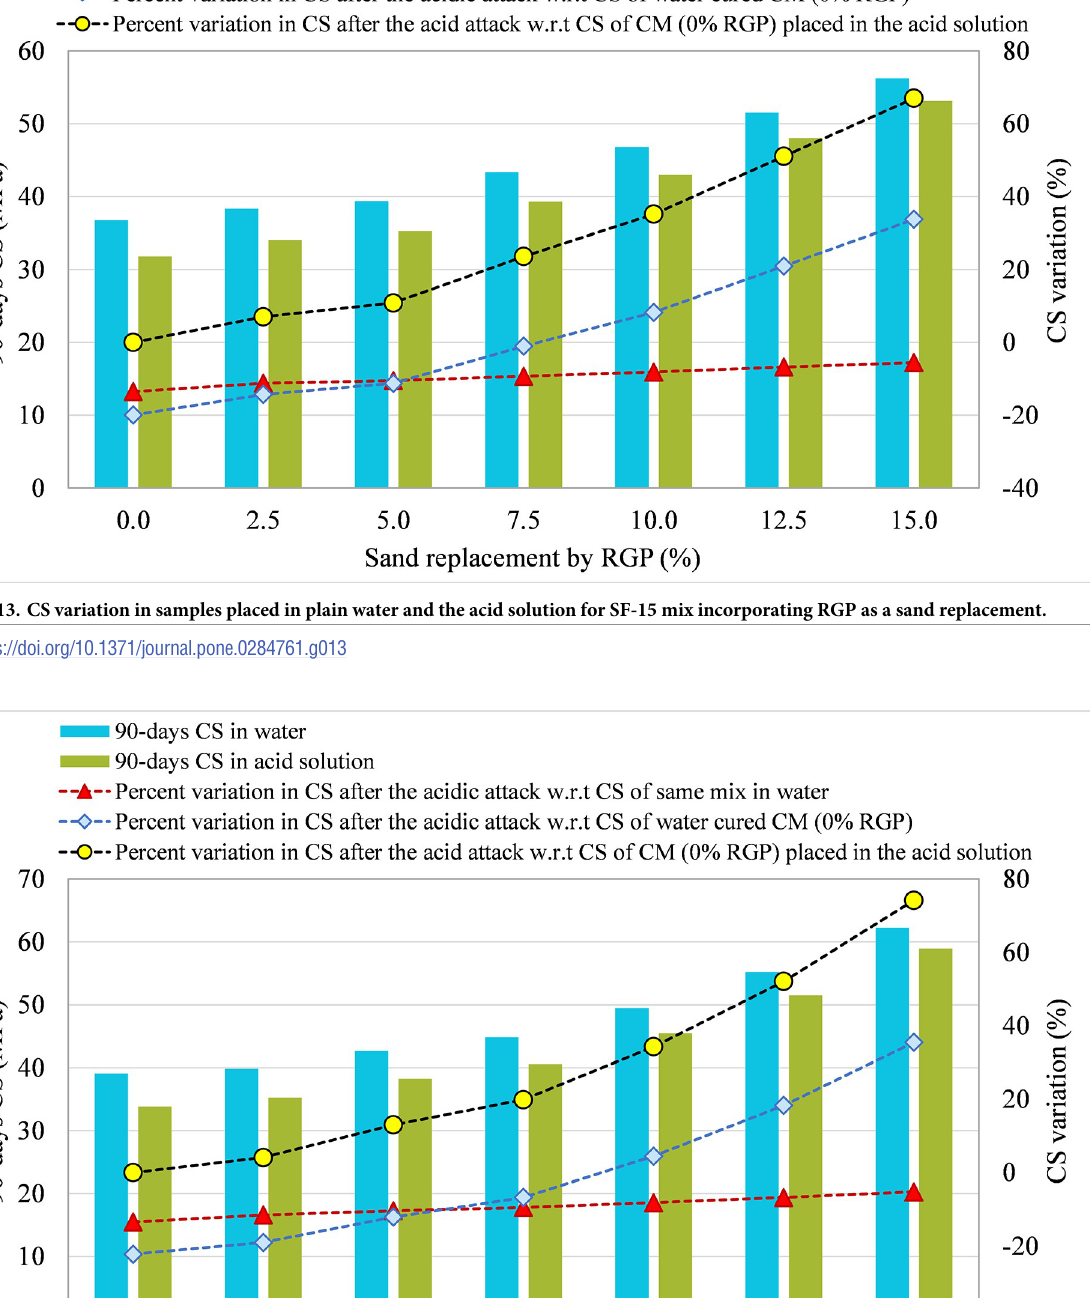
PLOS ONE | https://doi.org/10.1371/journal.pone.0284761 April 24, 2023 16 /